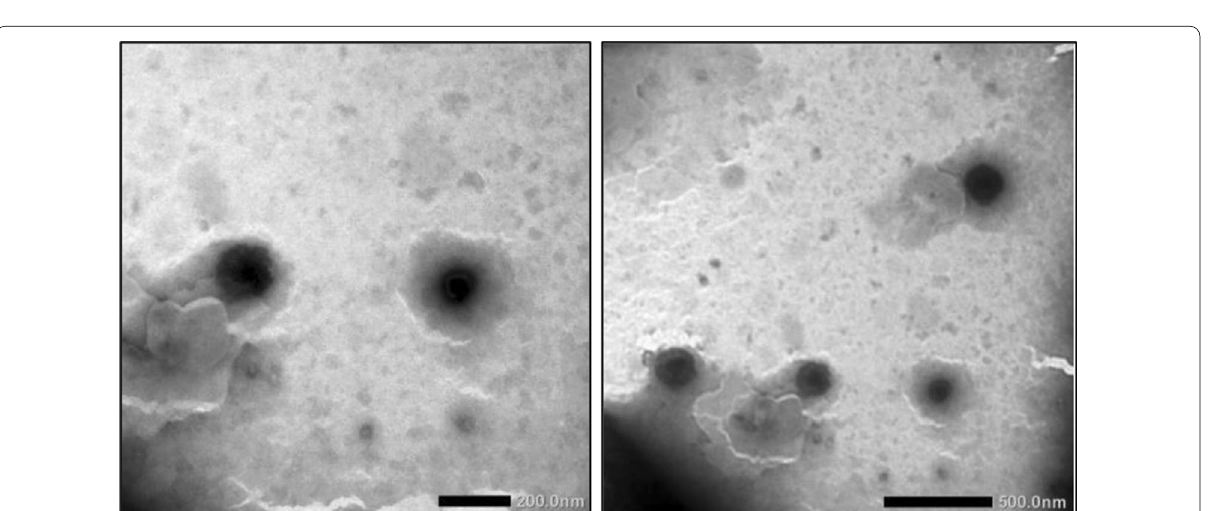
Fig. 11 TEM analysis of optimized boswellic acid transferosomes at 20,000